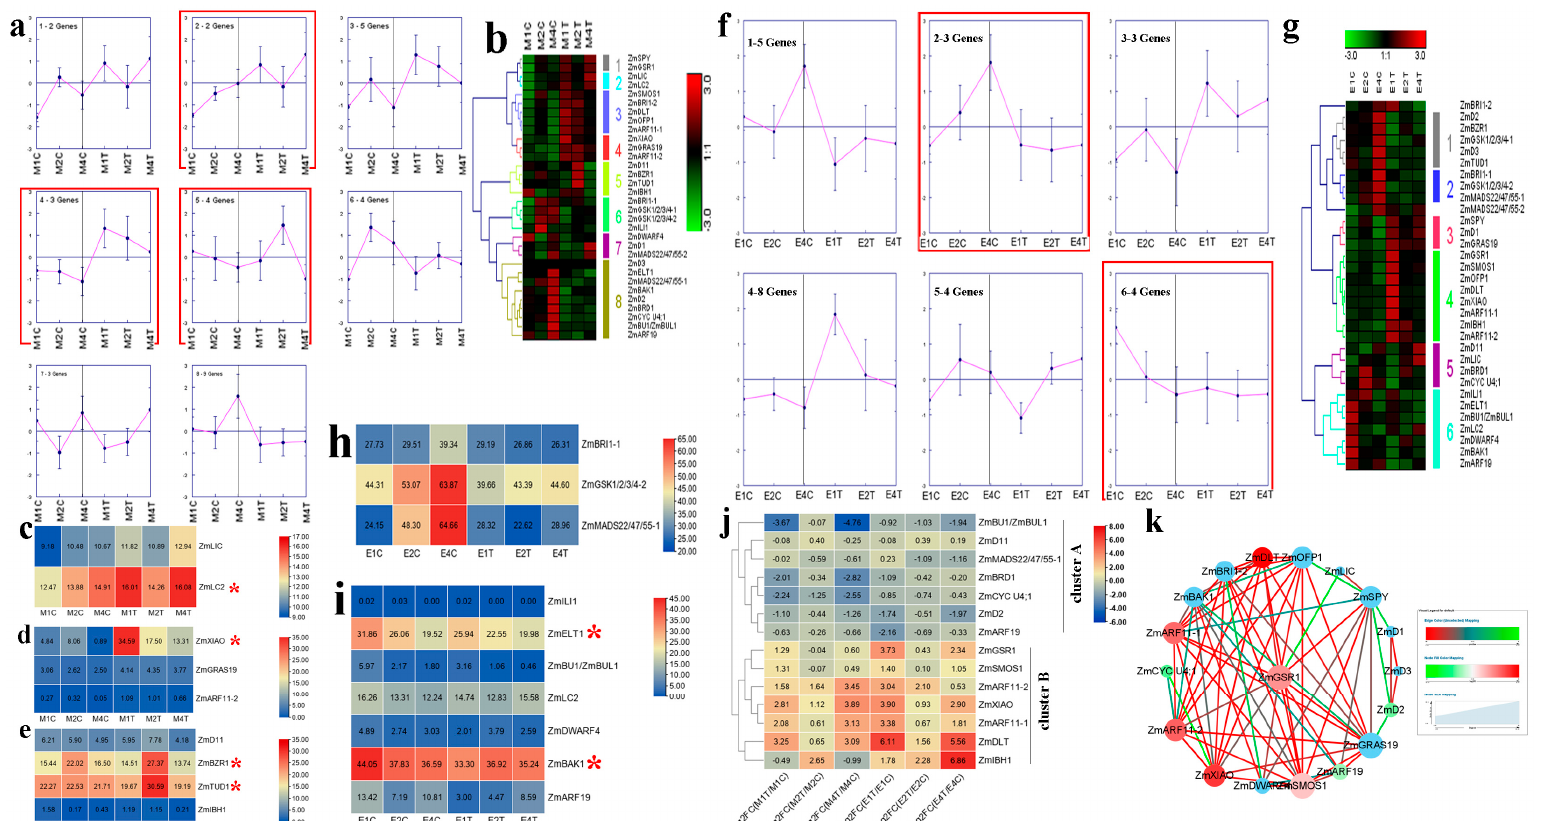
Figure 4. Trends and expression analyses of maize BR-related genes in response to coronatine. ( a ) Clusters based on expression data of maize BR-related genes in meristem region of ninth internode. Clusters showing similar or opposite patterns as target trait are marked with red rectangles. ( b ) Heatmap of all clusters in meristem region of ninth internode. ( c ) Expression levels of genes in cluster 2 at meristem region of ninth internode. ( d ) Expression levels of genes in cluster 4 at meristem region of ninth internode. ( e ) Expression levels of genes in cluster 5 at meristem region of ninth internode. ( f ) Clusters based on expression data of maize BR-related genes in elongation region of ninth internode. Clusters showing similar or opposite patterns as target trait are marked with red rectangles. ( g ) Heatmap of all clusters in elongation region of ninth internode. ( h ) Expression levels of genes in cluster 2 at elongation region of ninth internode. ( i ) Expression levels of genes in cluster 6 at elongation region of ninth internode. ( j ) Expression pattern analysis of maize BR-related genes in response to coronatine. ( k ) Gene co-expression network analysis of maize BR-related genes. Genes with high expression are marked with a red